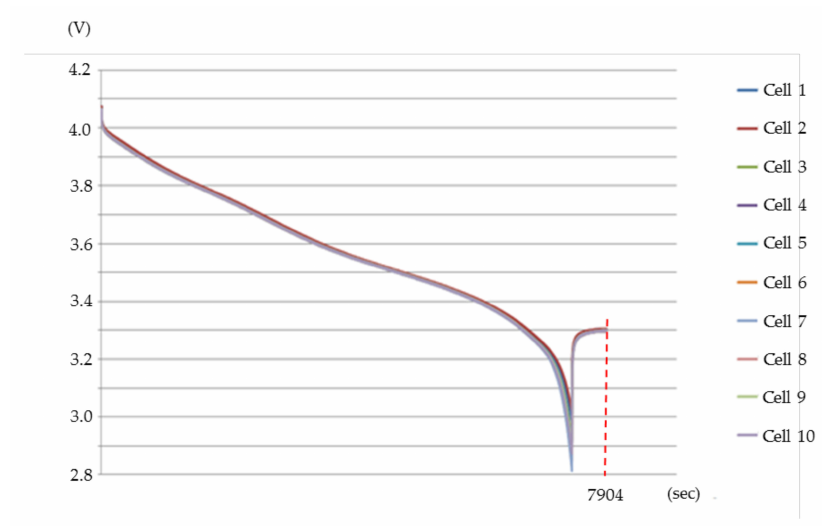
Figure 10. Discharge curve measured by voltage recorder.